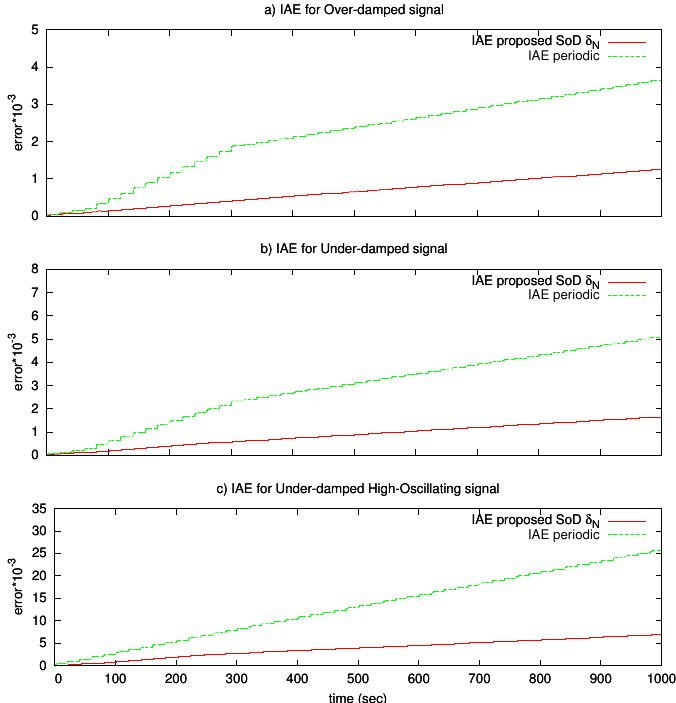
Figure 7. Integral Absolute Error (IAE) results of the proposed algorithm and the conformant periodic transmission for the three